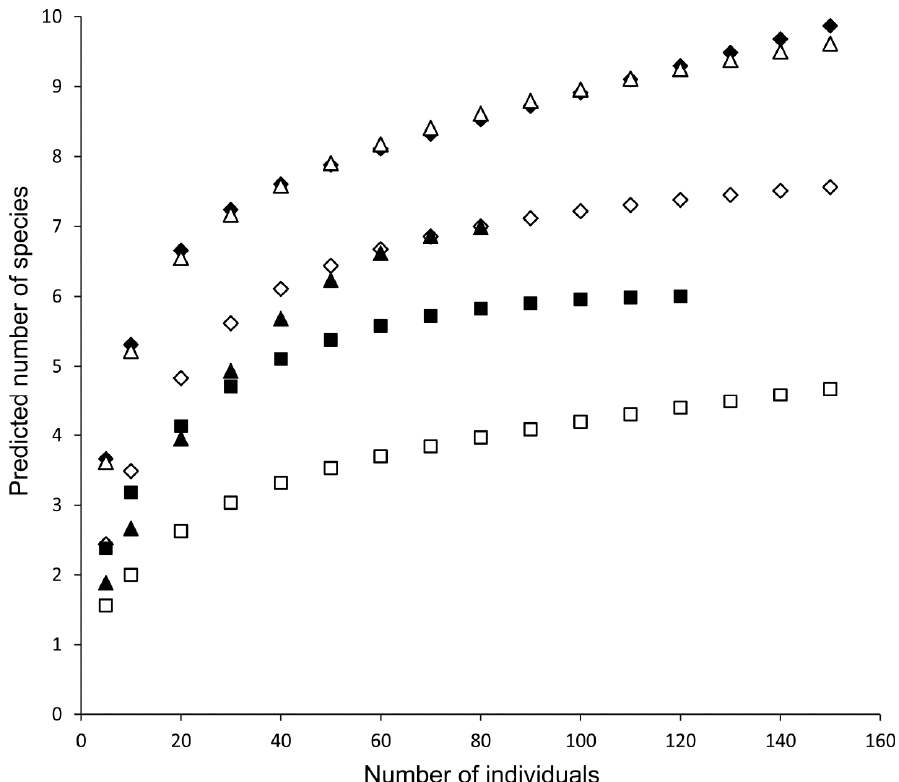
Figure 4. Rarefaction curves showing the numbers of species expected for particular numbers of individuals collected. The curve steepness at its initial part indicates the community evenness (the higher steepness, the higher evenness), whereas the curve height shows the number of species. Filled symbols are pre-invasion and clear symbols are post invasion for S1 ( ◊ ), S2 ( Δ ), and S3 ( □ ).